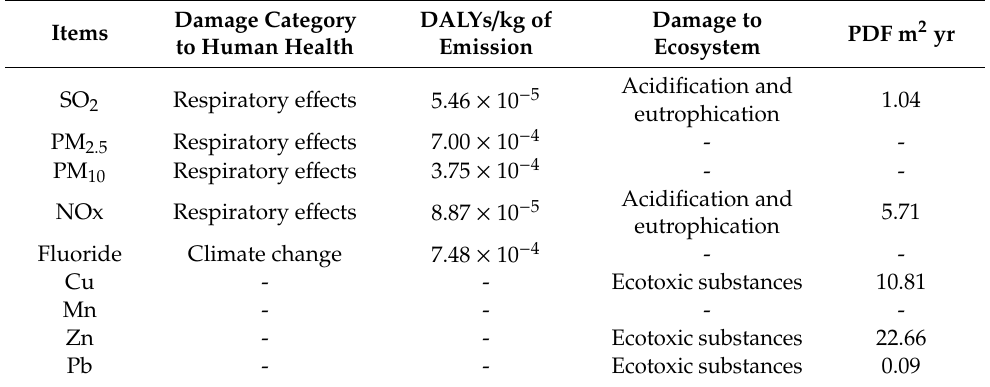
Table A2. Pollutants considered and the related